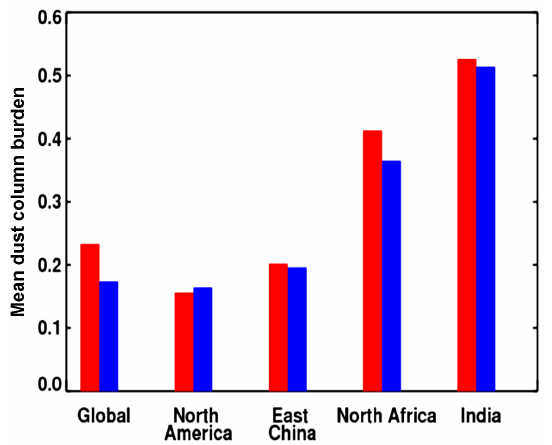
Figure 4. Mean dust column burdens (gm − 2 ) of mixed dust (red) and natural dust (blue) in the global and four geographical semi-arid regions.